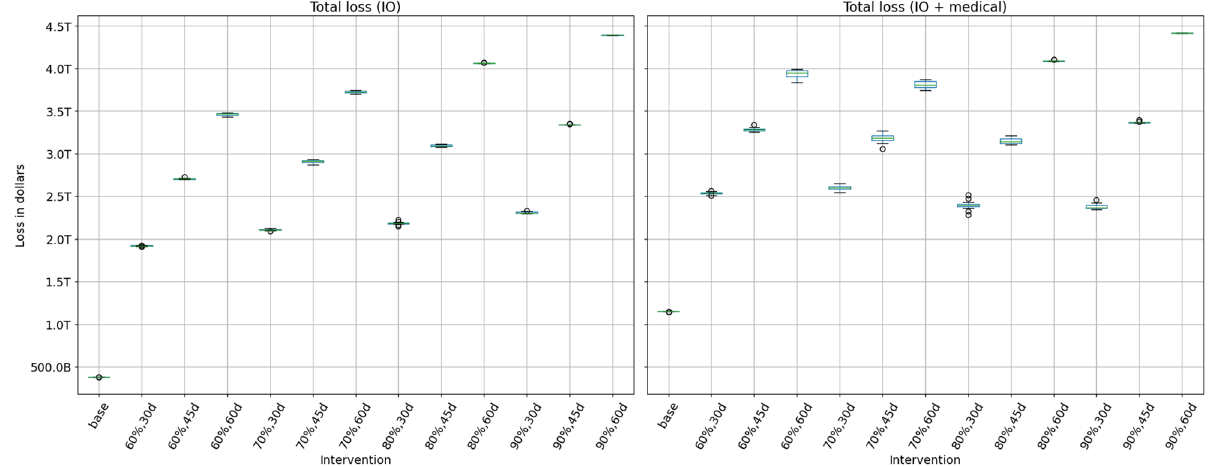
Figure 5. The left subfigure shows I–O economic losses (without medical costs) due to NPI measures and infections for each of the scenarios. The percentages show compliance to NPIs and “d” is for the duration of the Stay-home order. These losses arise from the drop in labor supply to sectors, caused by the lockdown, illness and mortality, and from interdependencies between sectors. It does not include the economic burden imposed by the treatment and medical services provided to the infected individuals, whereas the right subfigure includes this medical in productivity is caused only by the drop in labor supply due to illness and deaths since there is no lockdown in place. However, in the unmitigated case, more than 117,000 lives are lost and over 116 million infections occur. Economic losses due to inoperability, NPIs and medical treatments. In Fig. 5, the right subfigure shows the losses that are included in the left Fig. 5 plus the economic burden caused by the medical treatment of the ill. Note that the total loss in the unmitigated case without medical costs is $0.38 trillion in left Fig. 5 whereas with medical costs, this loss increases to $1.15 trillion as shown in the right Fig. 5. The extra $0.8 trillion is solely due to the medical costs of treating infections in the unmitigated case. Note that for a given compliance level, a longer SH always results in a higher loss. However for a given SH duration, a higher compliance may result in a lower or higher loss. This would depend upon the relative gain from reduced infections versus the losses from SH of healthy individuals. For example, in right Fig. 5 when the SH duration is set at 60 days, increasing compliance from 60 to 70% decreases the economic loss but increasing compliance from 70 to 80% increases the economic loss. This is because compliance has a non-linear effect on losses. At low levels of compliance, the marginal effect of a small increase in compliance is high because it helps get the pandemic under control which implies less absentee- ism due to illness and lower medical costs. An increase in compliance from 70 to 80% does not have the same incremental effect on infections because 70% compliance is already quite effective, but has a large effect on the inoperability of sectors because a larger critical mass of workers are staying home. Trade‑offs between compliance and duration of lockdown. Both subfigures in Fig. 5 show that there are tradeoffs between compliance and the length of the SH order. Low compliance can be compensated by a longer SH order and a shorter SH order can be combined with a higher compliance level to reach the same level of total loss. For example, in left Fig. 5, a 60% compliance rate combined with a 60 days of SH results in similar total loss as a 90% compliance rate combined with a 45 days of SH. The best outcome is reached when the lockdown is for 30 days and the compliance rate is at least 80%, as shown in the right Fig. 5. It is clear that a lengthy SH order is harmful to the economy so a short SH order com- bined with a high level of compliance is ideal. Note that these tradeoffs and losses do not include the long term effect of deaths, i.e. the permanent loss in productivity, and only consider loss in labor supply for the duration of the simulation. The number of deaths depend on the duration and compliance to NPIs and are an important met- ric in measuring the outcomes. Later plots show the number of infections and deaths averted under each scenario. Infections and deaths averted versus economic loss. Figures 6 and 7 show the trade-off between the number of infections-averted and economic losses, as well as the number of deaths-averted vs. economic losses respectively, under each of the intervention scenarios. Several important observations can be made from these plots: (i) The base case, where no NPIs are in place has the least loss but results in over 100 million infections and over 100,000 deaths. (ii) The trend for both morbidity and mortality is the same under different scenarios. (iii) Losses rise with longer durations of SH order. (iv) A SH order of 45 days results in same economic loss whether the compliance is at 70% or 80%. However the numbers of infections and deaths averted are much higher at 80% compliance. (v) Similarly, once 90% compliance is reached, an increase in SH duration from 45 to 60 days does not reduce infections and deaths but adds more than one trillion in economic losses. (vi) A longer lockdown